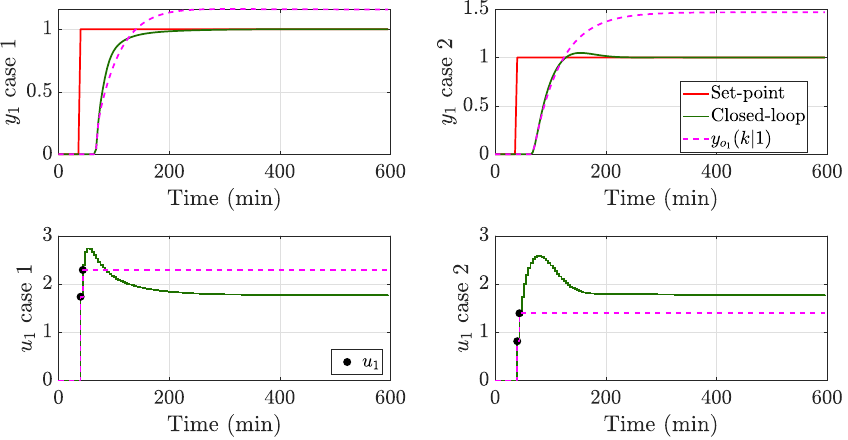
Figure 6. Determination of the prediction and control horizons of the HOF output y 1 and input u 1 .